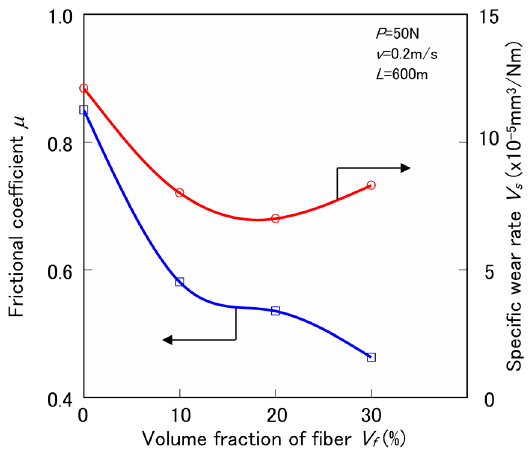
Figure 4. Tribological properties of various surface-treated HF/PA1010 biomass composites with ureidosilane coupling agents (S3).